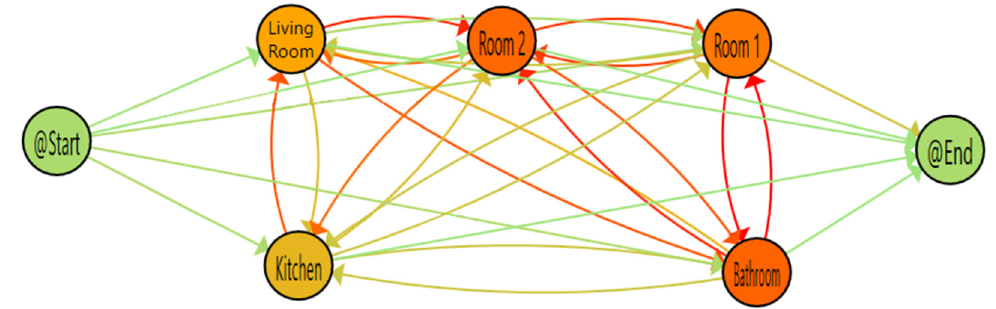
Figure 11. Parallel activity log inference algorithm (PALIA) timed parallel automaton (TPA) for CASAS using wide-area sensors.